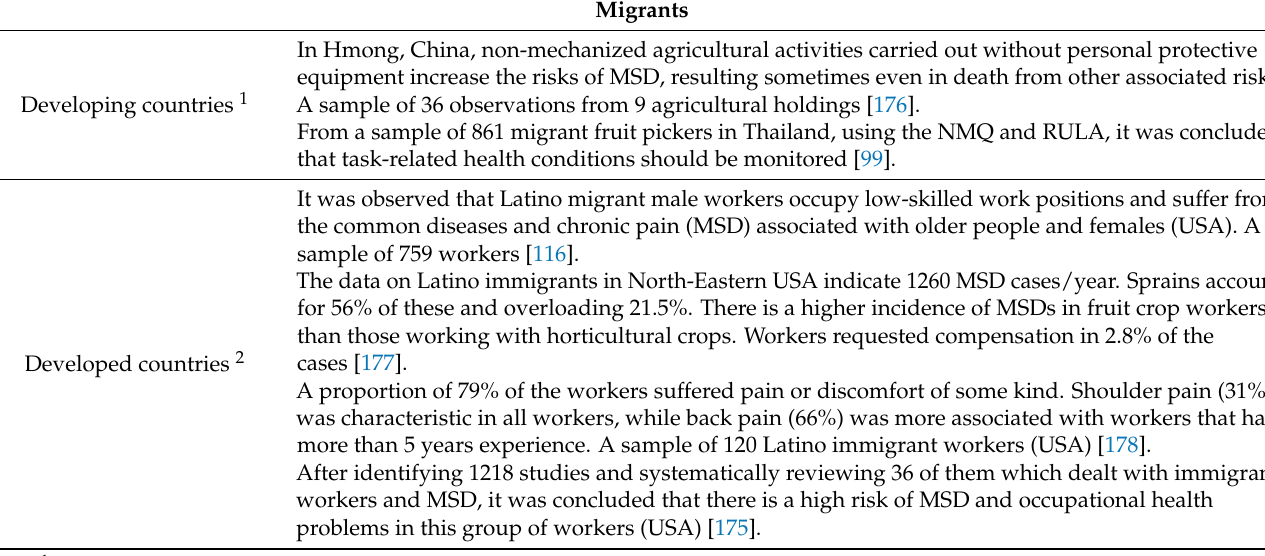
Table A15. MSD research in agriculture (1995–2020). Category: Migrants. Migrants